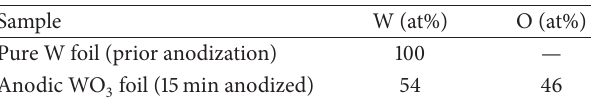
Table 1: Average elemental compositions (at%) of pure W foil